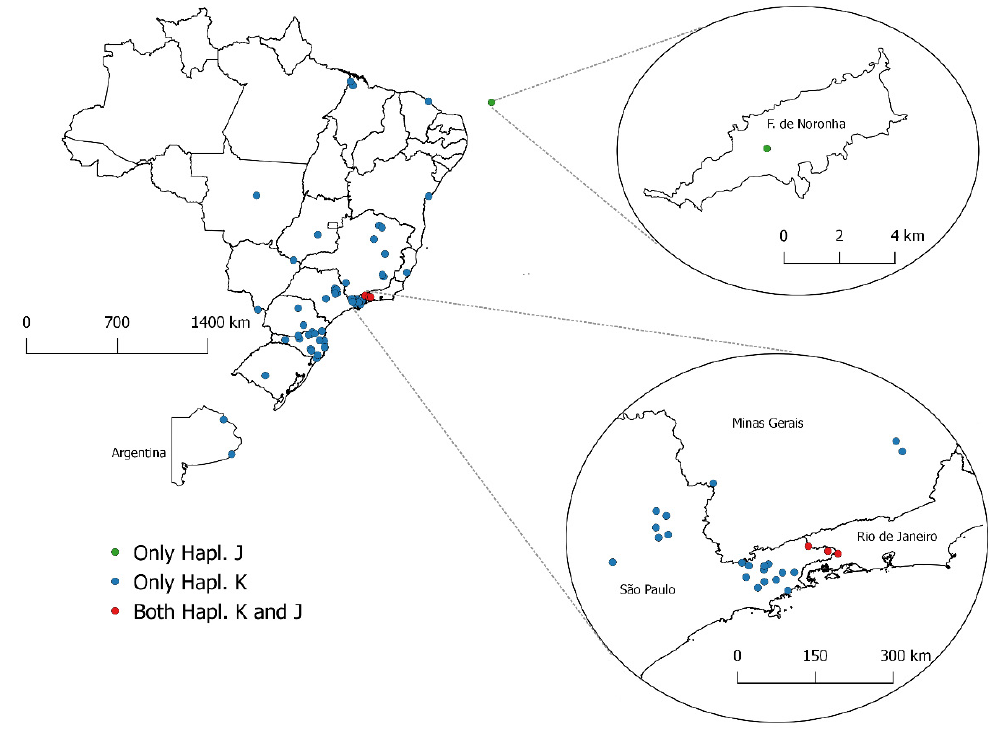
Fig 1 . Representative map from evaluated regions. Dots represent each municipality where samples were taken to genetic characterization of mites. Blue dots represent places where only K haplotype was found. Green dot represents where only J haplotype was found. Red dots represent where both haplotypes were found coexisting in a same colony or in a same sampling site.